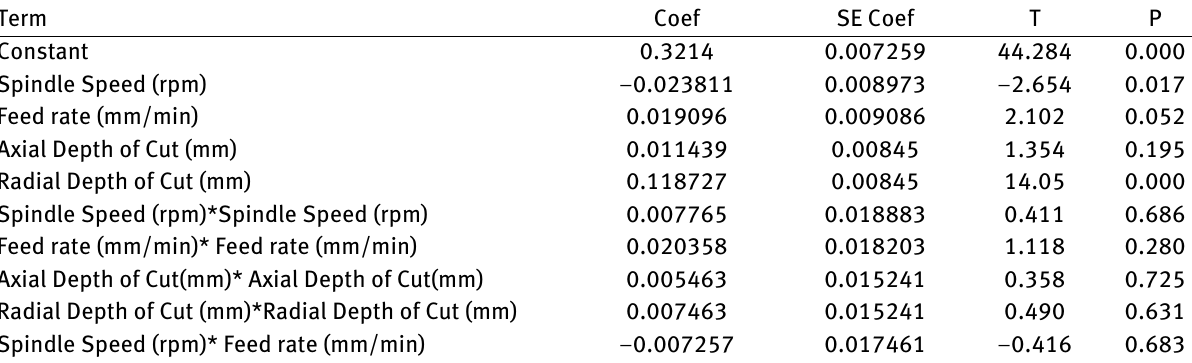
Table 5: Tool wear, VB max estimated regression coeflcients.